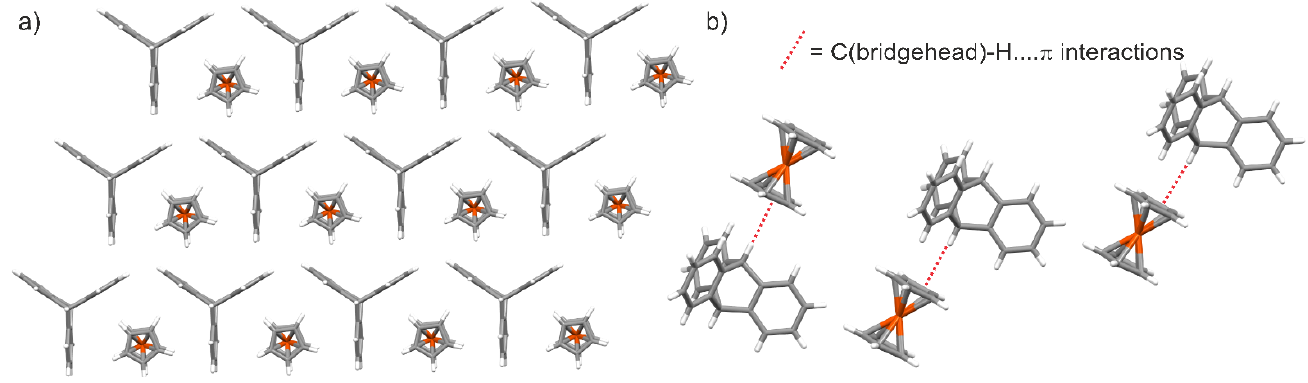
Figure 6. The triptycene–ferrocene cocrystal: ( a ) a honeycomb fragment showing the efficient pack- ing within the cocrystal; ( b ) the interaction between the C(bridgehead)-H and the aromatic ring of ferrocene [163].